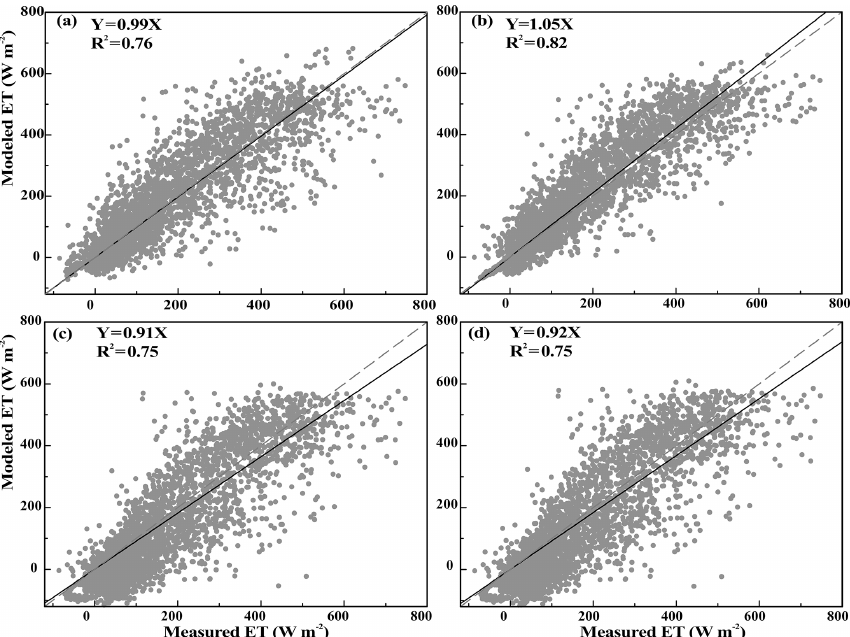
Figure 3. Regressions between measured and modeled half-hourly ET values produced by different models from DOY 154 to DOY 270: (a) PM, (b) SW, (c) PT–FC, and (d) AA. The regressions are Y = 0 . 99 X ( R 2 = 0 . 76), Y = 1 . 05 X ( R 2 = 0 . 82), Y = 0 . 91 X ( R 2 = 0 . 75), and Y = 0 . 92 X ( R 2 = 0 . 75) for the PM, SW, PT–FC, and AA models,